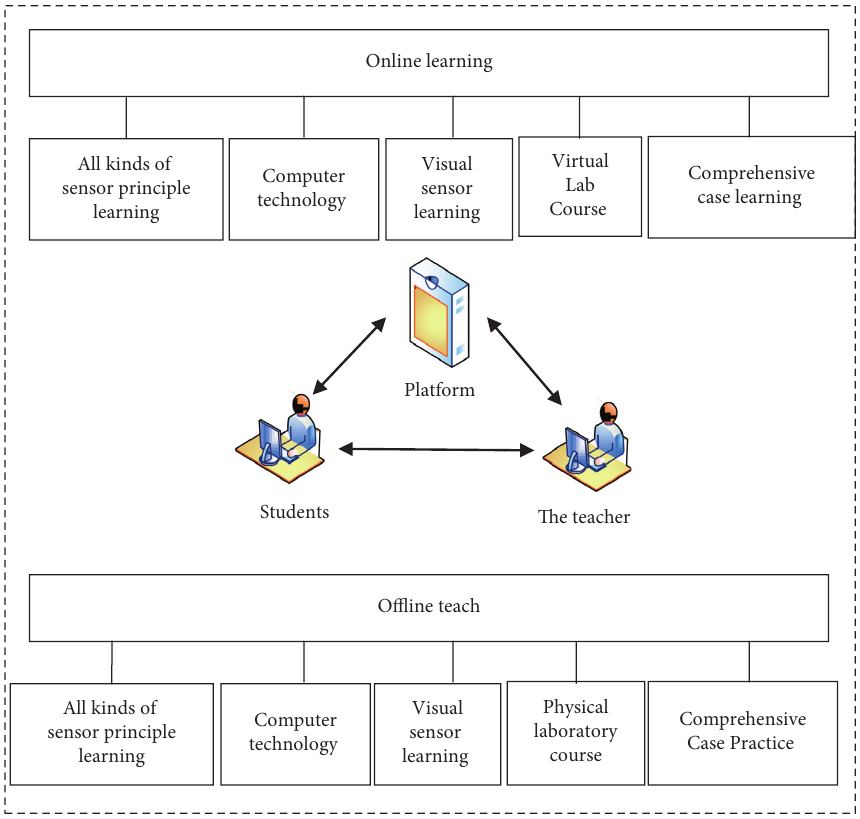
Figure 6: Content map of improved visual sensing design